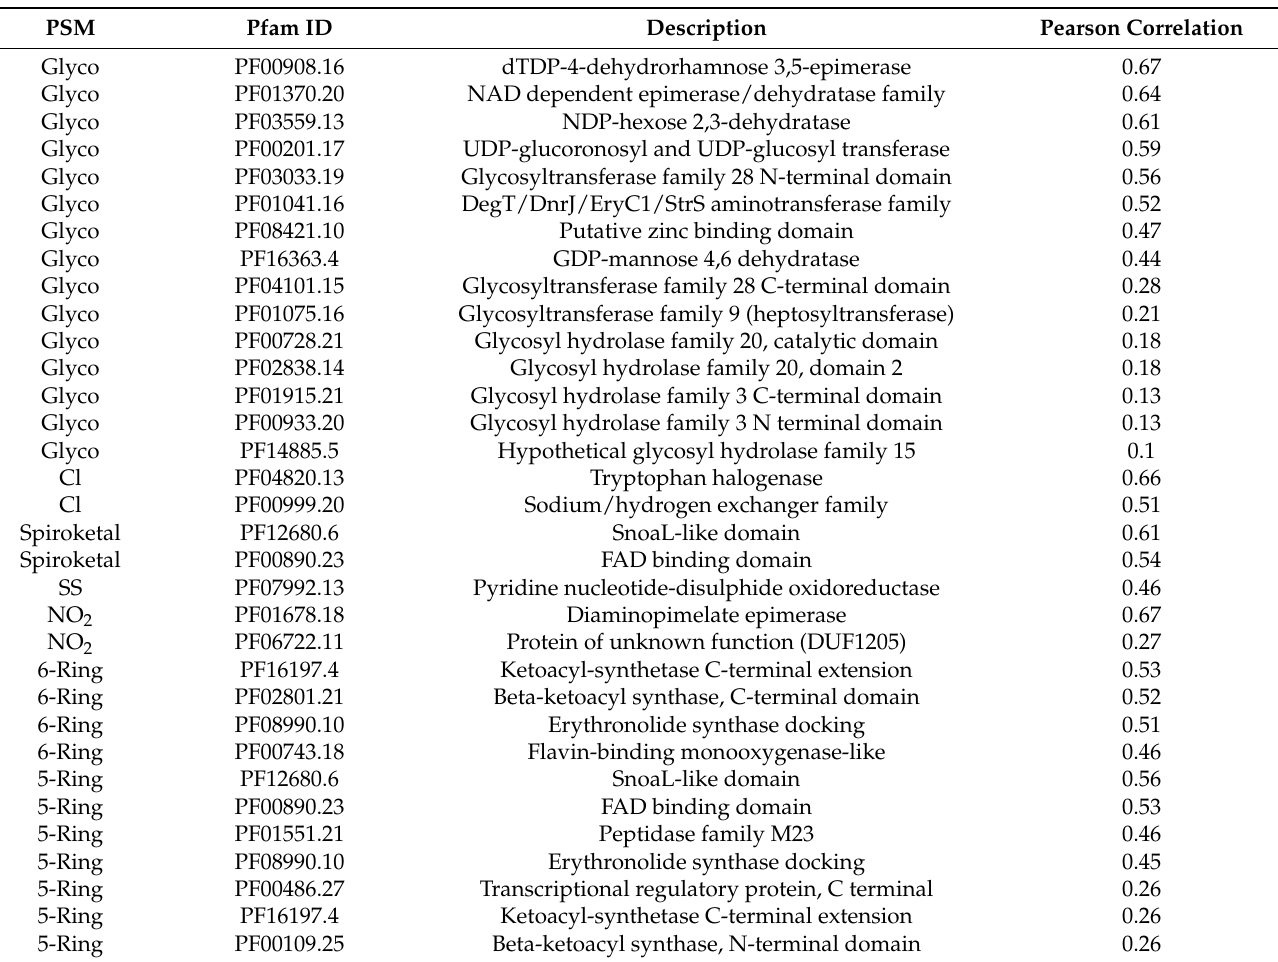
Table 7. Selected Pfam domains and corresponding PSMs. The number of appearances of a certain PSM in the structure of a secondary metabolite is correlated to the number of Pfam domains found in the producing cluster. The descriptions are derived from the Pfam database. Pfam-derived abbreviations are: deoxythymidine diphosphate (dTDP), nicotinamide adenine dinucleotide (NAD), nucleoside diphosphate (NDP), uridine diphosphate glucose (UDP), guanosine diphosphate (GDP), flavin adenine dinucleotide (FAD), domain of unknown function (DUF).